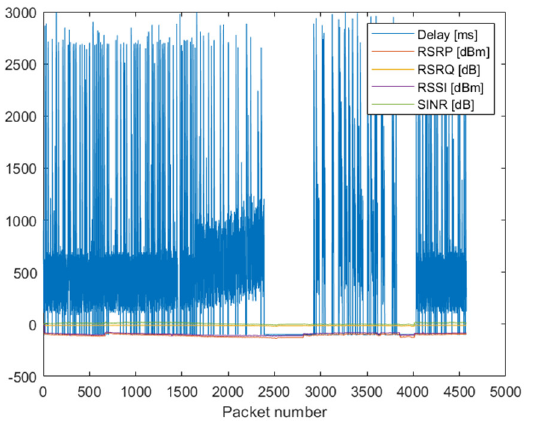
Figure 4. Measurements results of RSRP, RSRQ, RSSI, SINR and transmission delay for NB-IoT technology.